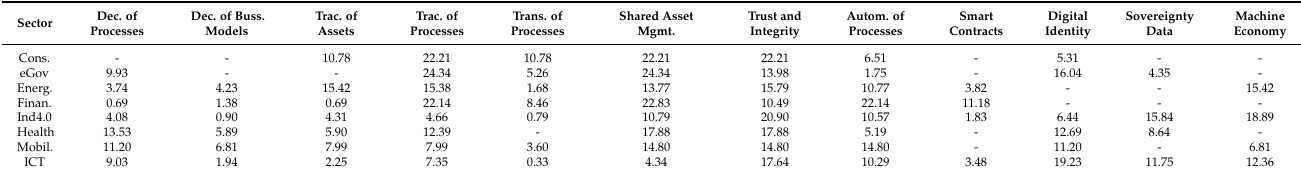
Table 3. Applications investment by sector